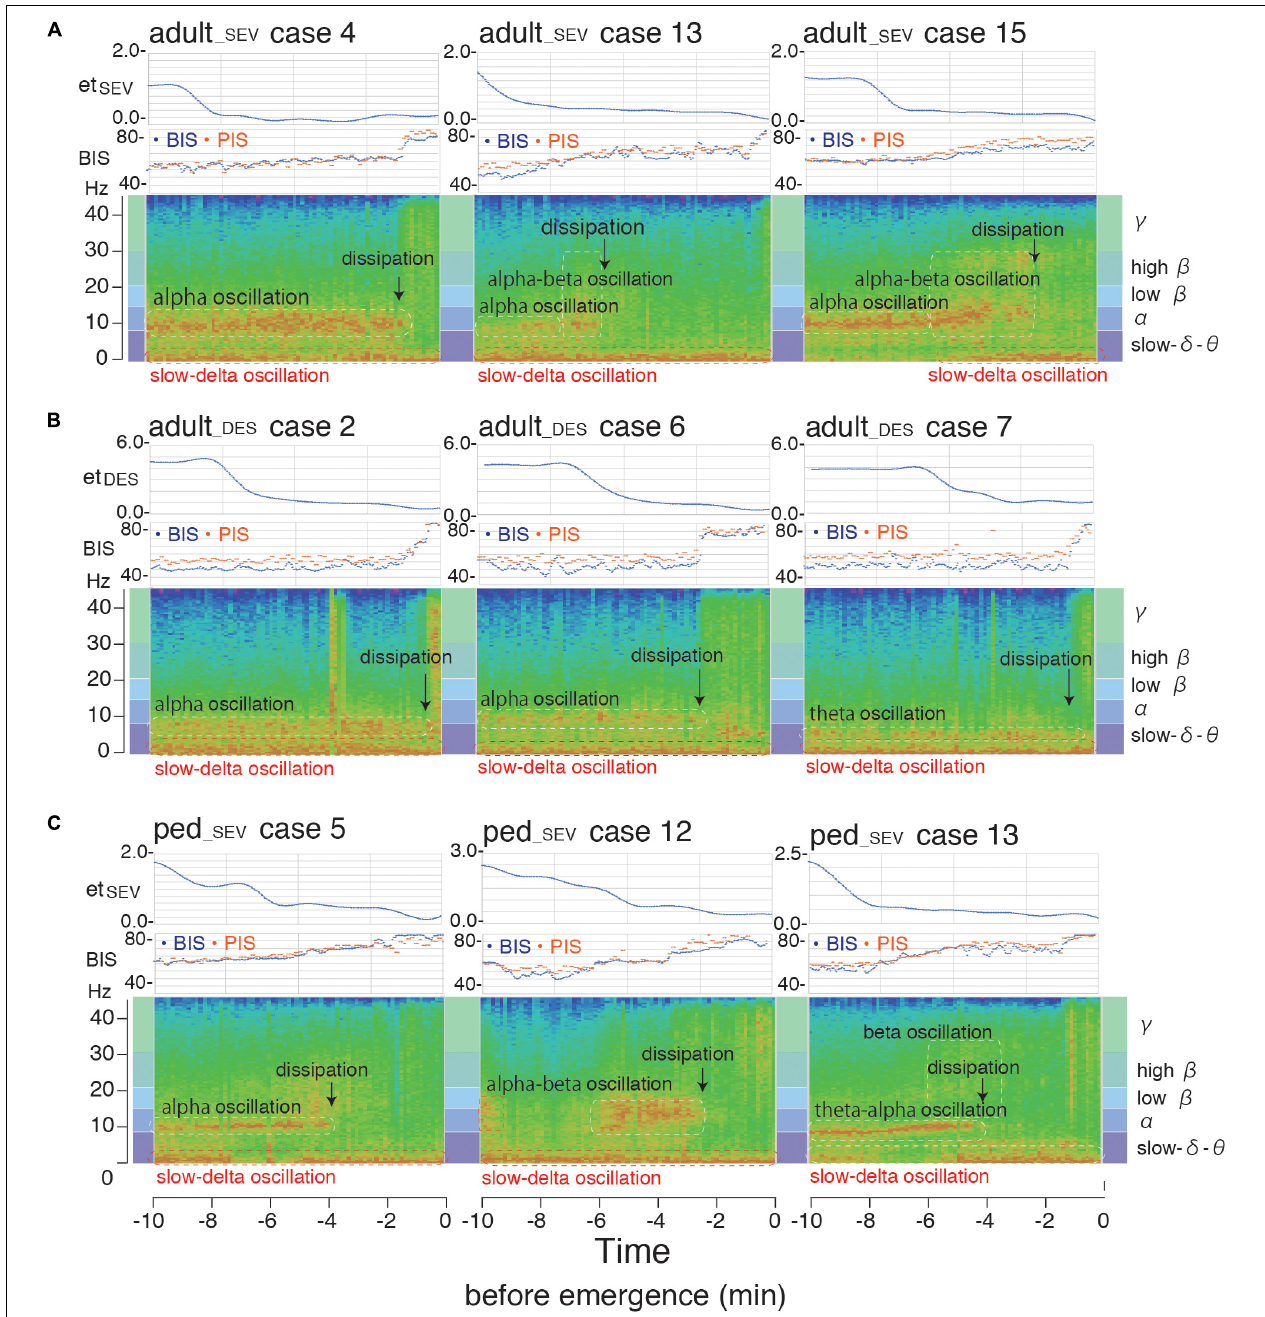
FIGURE 8 | Spectrogram from the hypnotic state to emergence from general anesthesia. Spectrograms of three representative cases [ (A) adult _ SEV , (B) adult _ DES , and (C) ped _ SEV ] from each of the three patient groups with time trends of BIS, PIS, et SEV , and et DES at 10 min before emergence from general anesthesia. Theta-to-alpha oscillations were observed before the dissipation points, after which beta-to-gamma oscillations were observed with abrupt increases of BIS and PIS. adult _ SEV , adult patients anesthetized with sevoflurane; adult _ DES , adult patients anesthetized with desflurane; ped _ SEV , pediatric patients anesthetized with sevoflurane; BIS, bispectral index; et SEV , end-tidal sevoflurane concentration; et DES , end-tidal sevoflurane concentration; PIS, Poincaré plot-integrated